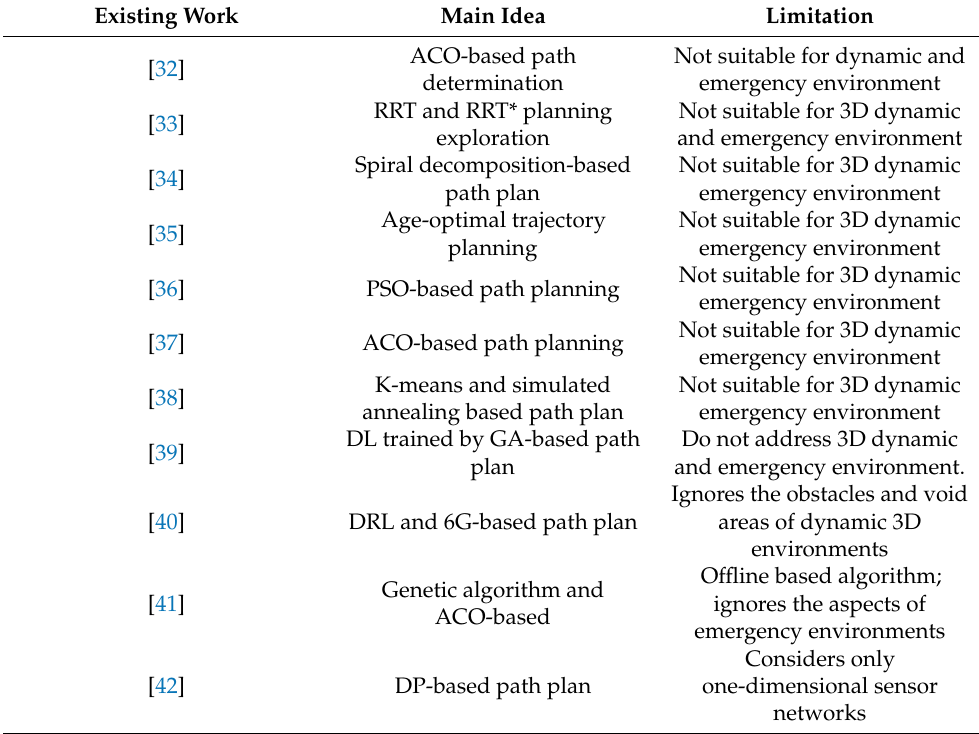
Table 1. Summary of the existing